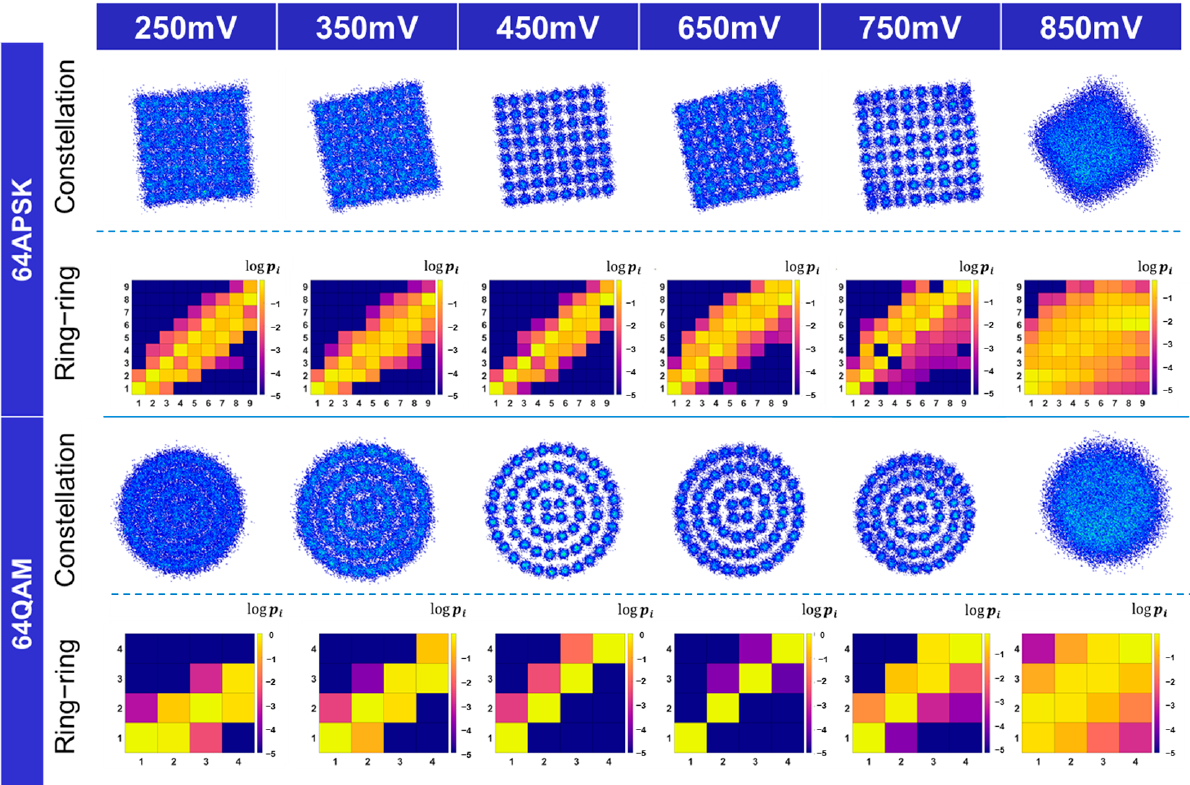
Figure 4. Constellation and ring–ring diagrams when waveform sets at other Vpp are applied to the model trained at 550 mV. The constellation demonstrates a clear phase shift and the ring–ring diagram shows the nonlinearity problem in high Vpp above 650 mV.